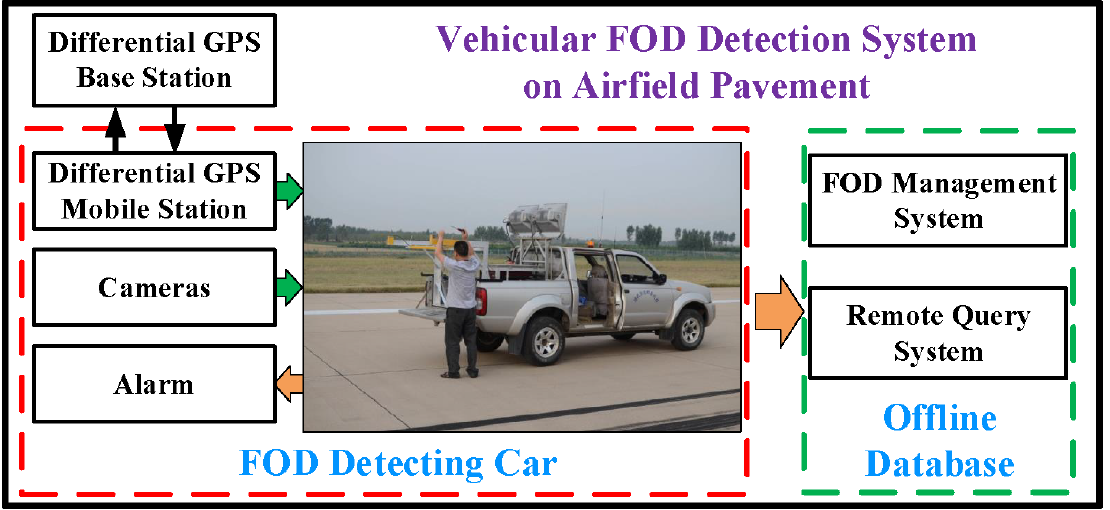
Figure 6. The framework of vehicular FOD detection system on airfield pavement.